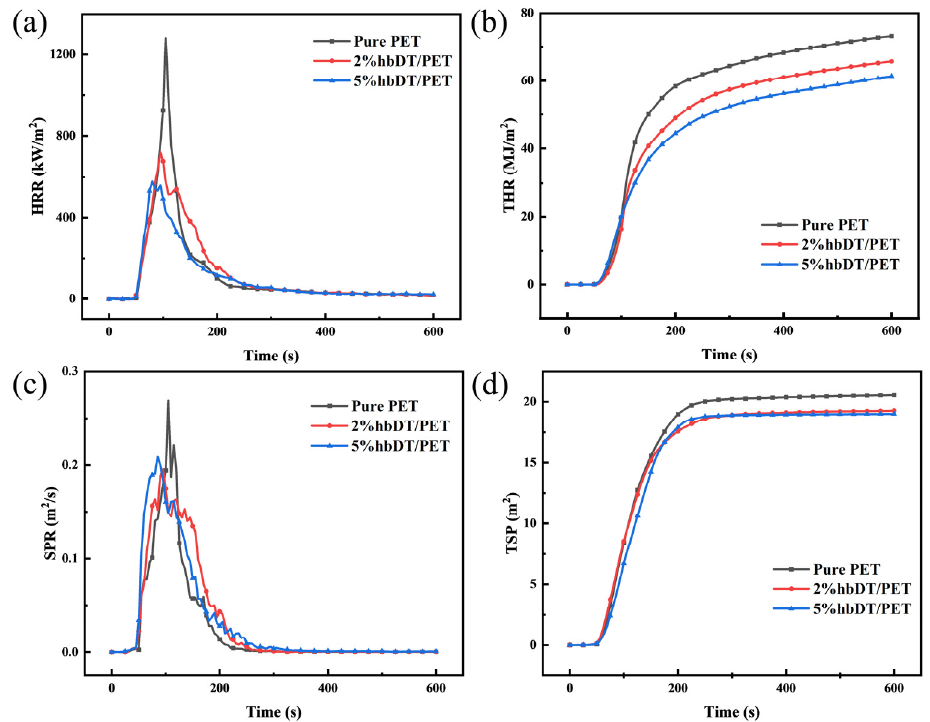
Figure 6. ( a ) Heat release rate (HRR), ( b ) total heat release (THR), ( c ) smoke production rate (SPR) and ( d ) total smoke production (TSP) curves of cone calorimeter test of pure PET and different hbDT/PET composites. Table 3. The cone calorimeter parameters of pure PET and hbDT/PET composites.